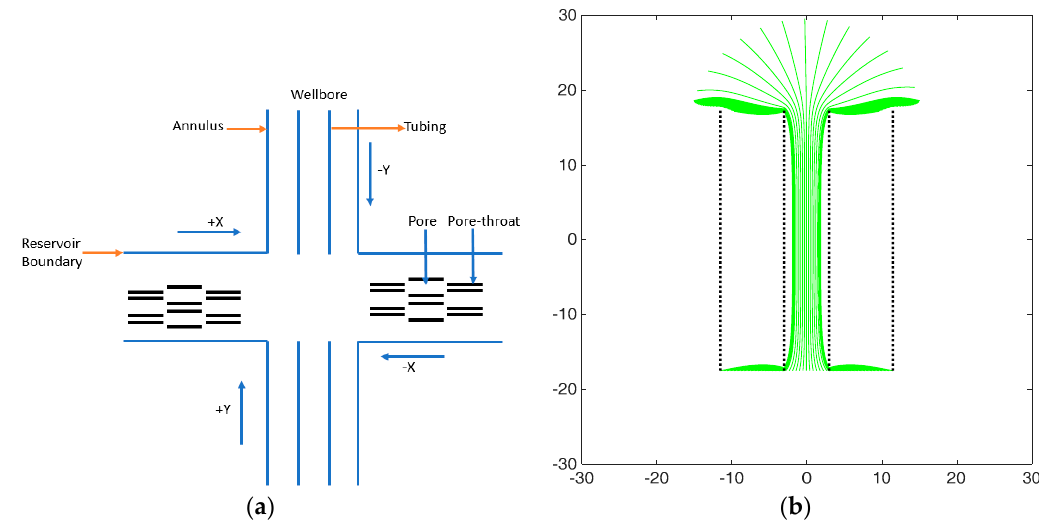
Figure 7. ( a ) Schematic of the reservoir–wellbore transition model with flow directions. ( b ) Production tube flow model with streamlines (green) for flow from reservoir to the wellbore obtained by solving the stream function using a particle tracking method based on incremental particle displacement in a Eulerian reference frame (as opposed to a Lagrangian reference frame). Length units are scaled in cm (both x-axis and y-axis).